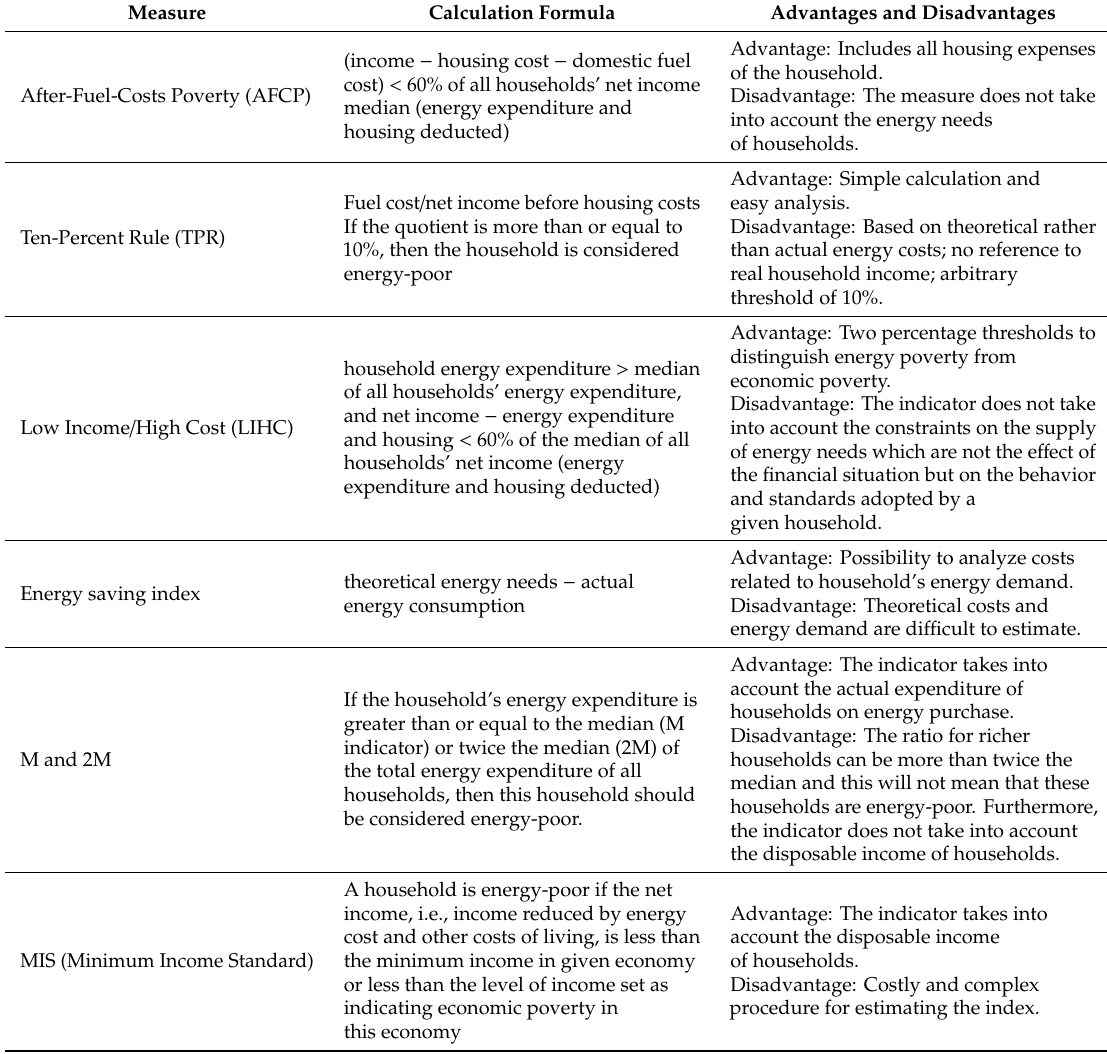
Table 1. Energy poverty